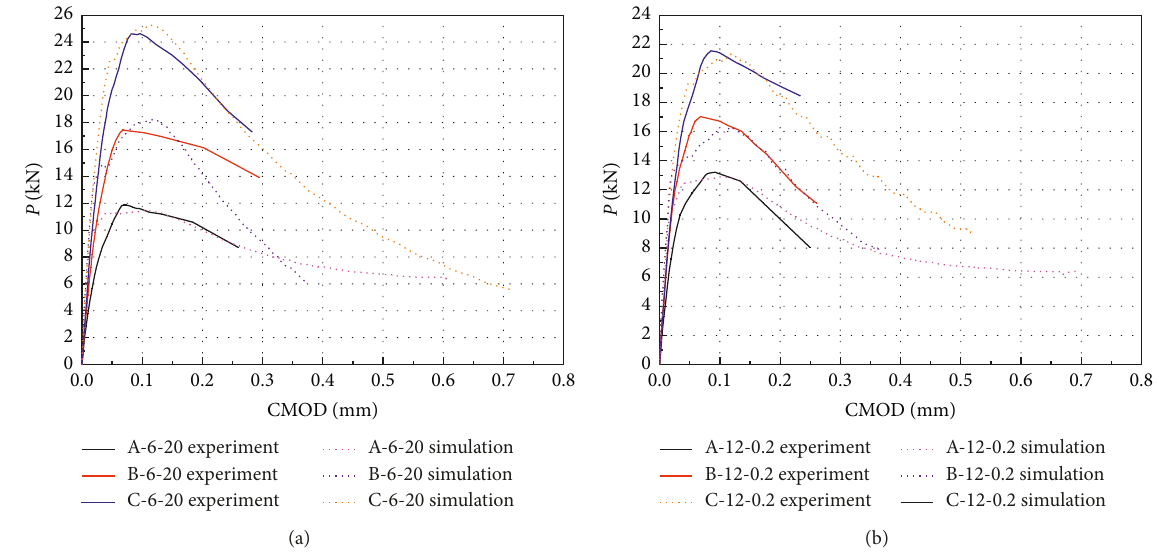
Figure 9: Comparison of results from numerical simulations and experiments. (a) 6mm BFRC. (b) 12mm